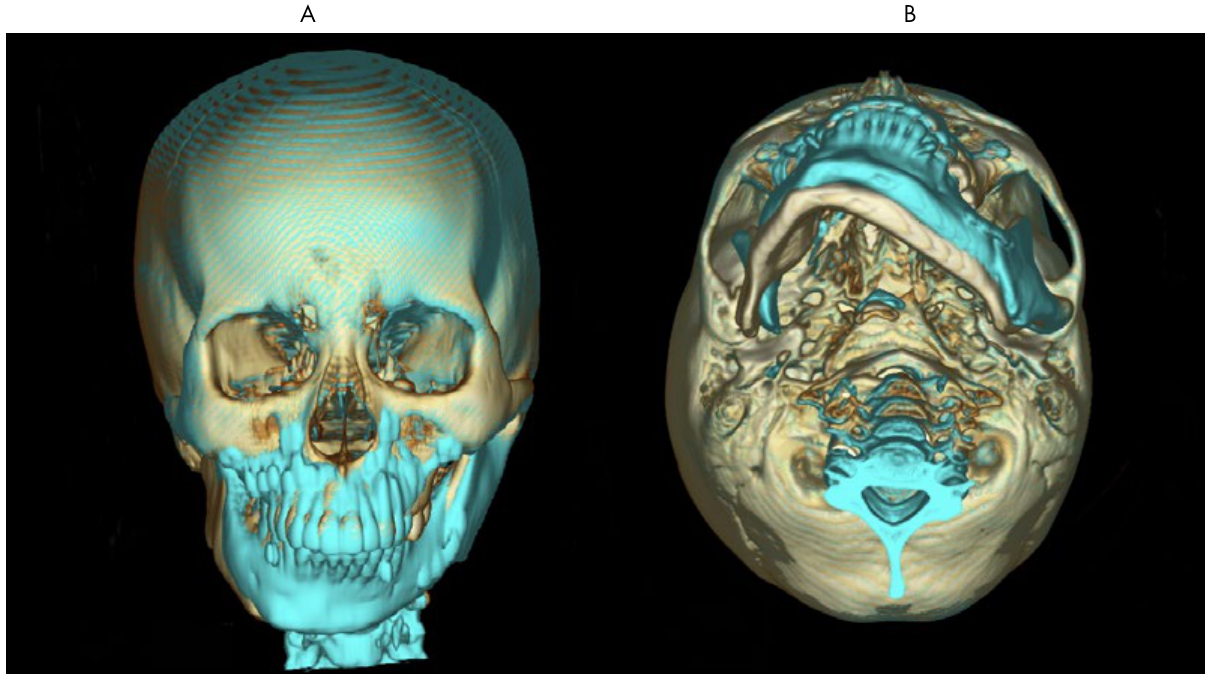
Figure 8. A superimposition of 3D CT images of the pretreatment: white; and post-treatment: blue. A: frontal view; B: inferior